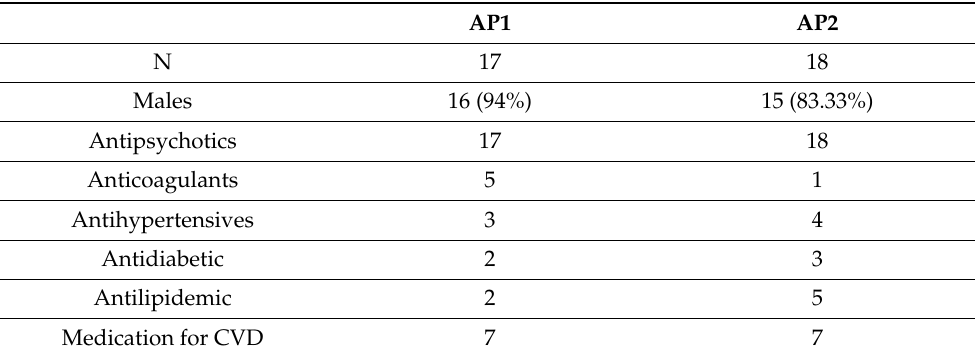
Table 1. Demographic and clinical characteristics of the forensic psychiatric patients at the start of the study (T1) (N = 35), according to the type of antipsychotic (AP) medication. AP1 AP2 N 17 18 Males 16 (94%) 15 (83.33%) Antipsychotics 17 18 Anticoagulants 5 1 Antihypertensives 3 Antidiabetic 2 Antilipidemic Medication for